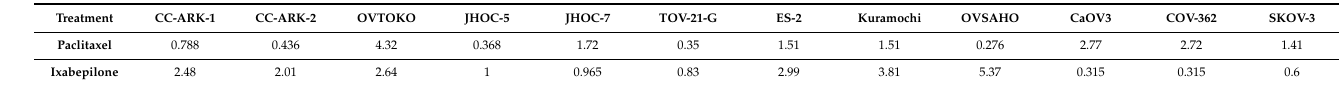
Table 2. Half maximal inhibitory concentrations for paclitaxel and ixabepilone in cell lines used in this